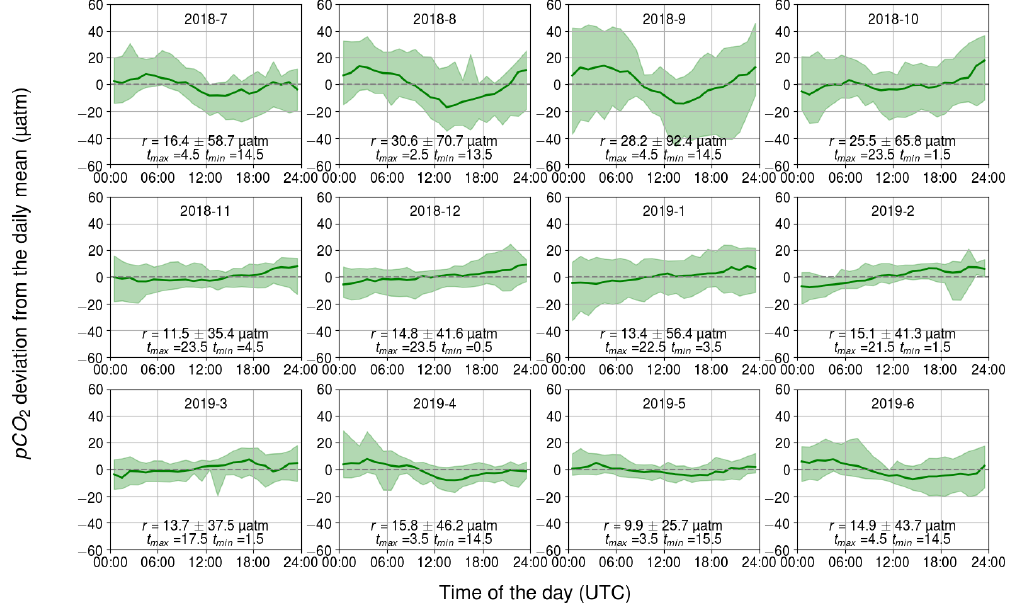
Figure 6. Observed monthly p CO 2 diurnal variability generated by biological transformations, showing the binned median and difference of the minimum of the 10th percentile and the maximum of the 90th percentile. The y axis shows the p CO 2 deviation (in µatm) and the x axis shows the hour of the day. Range, r , and the time for the maximum and minimum p CO 2 are also